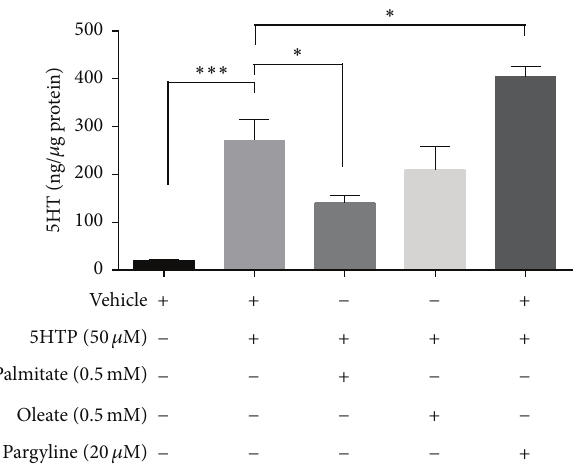
Figure 5: Intracellular 5HT content in NEFAs-treated MIN6 𝛽 - cells. MIN6 𝛽 -cells were supplemented with or without the 5HT precursor 5HTP (50 𝜇 M) and treated with palmitate (0.5mM), oleate (0.5mM), or the Mao inhibitor Pargyline (20 𝜇 M) during twenty-four hours. Then, cells were collected and homogenized and the protein was separated by PCA precipitation. The 5HT concentration was quantified by HPLC in supernatant and adjusted to total protein content (see Section 2). Graph bars represent mean ± standard errors of measurements of three independent experiments in duplicate. The symbol ∗ denotes 𝑝 < 0.05 and ∗ ∗ ∗ denotes 𝑝 < 0.001 in one-way